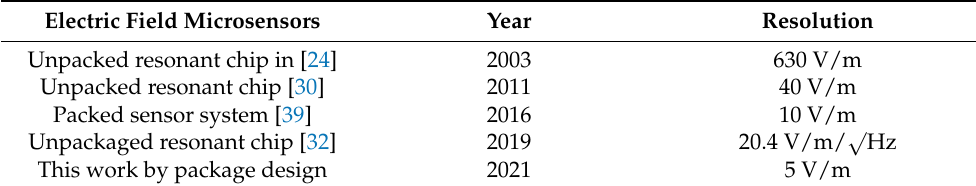
Table 2. Comparison of electric field resolution with previous